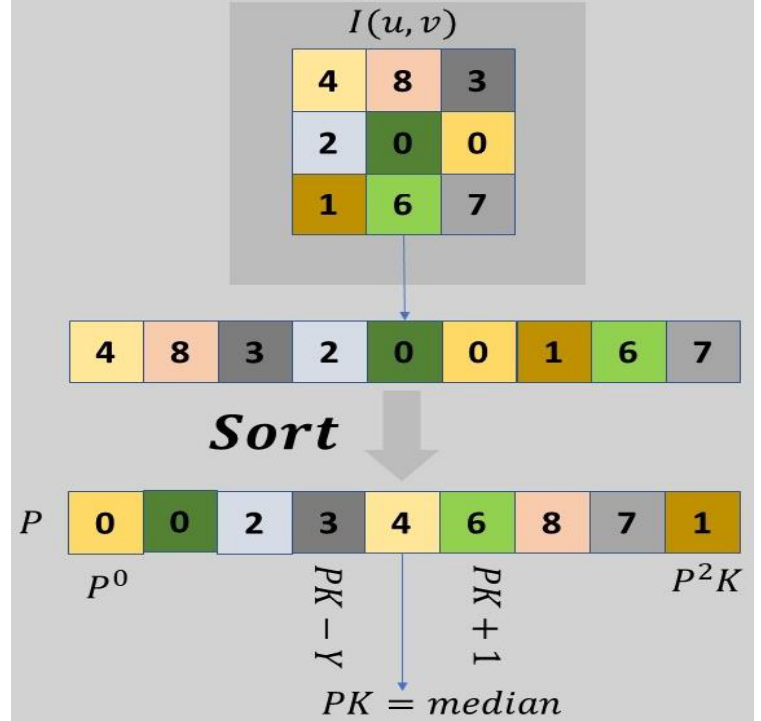
Figure 5. The working of the median filter for noise removal.